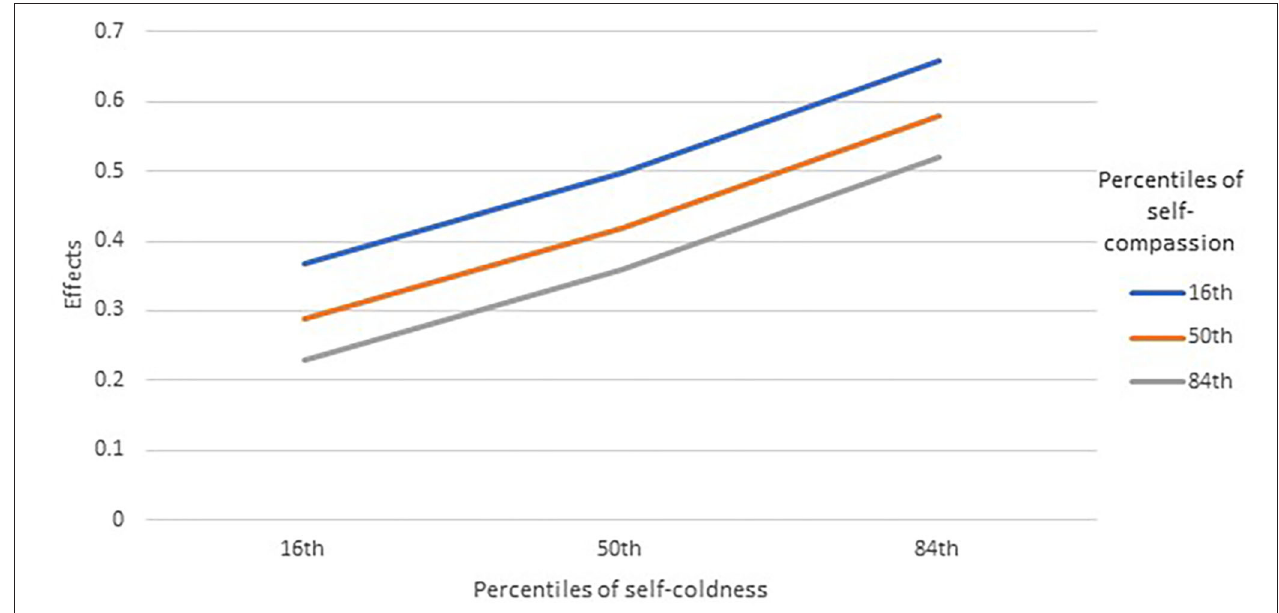
FIGURE 1 | Moderation roles of self-compassion and self-coldness on the effects between perceived threats and psychological distress ( N = 761). Effects were unstandardized coefficients of the conditional effects of perceived threats on psychological distress.